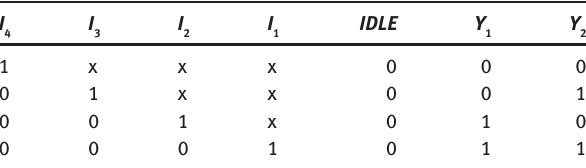
Table 1: Truth table of the optical priority